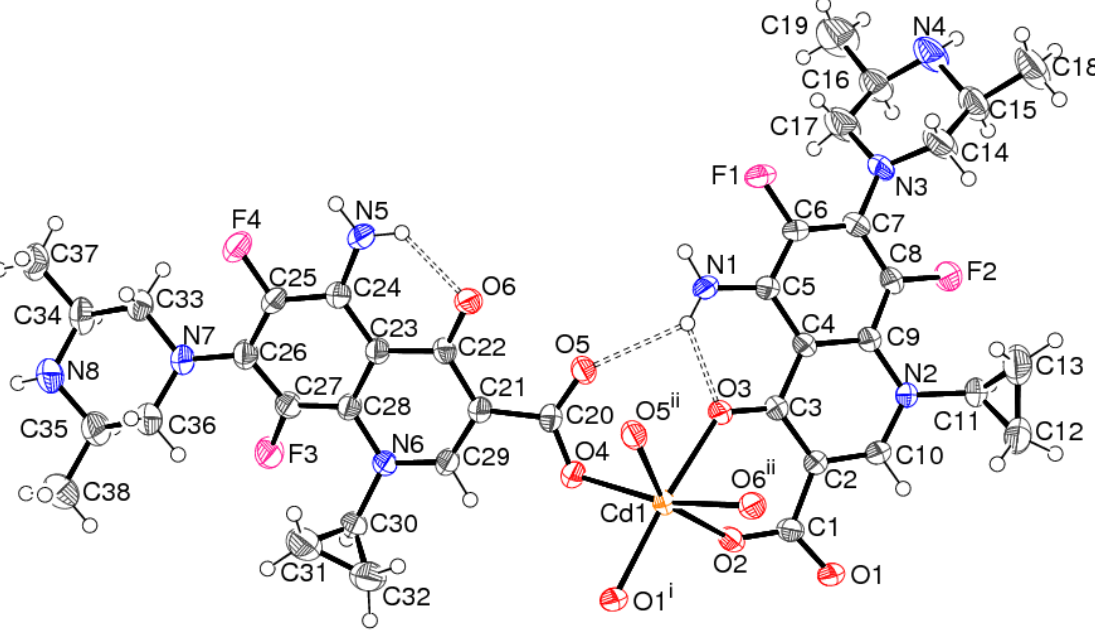
Figure 2. The asymmetric unit of 1 (50% displacement ellipsoids), expanded to show the complete Cd 2+ coordination sphere. Hydrogen bonds are shown as double-dashed lines and the minor disorder components of the piperazine rings of the ligands and the disordered, uncoordinated water molecule are omitted for clarity. See Table 1 for symmetry codes.